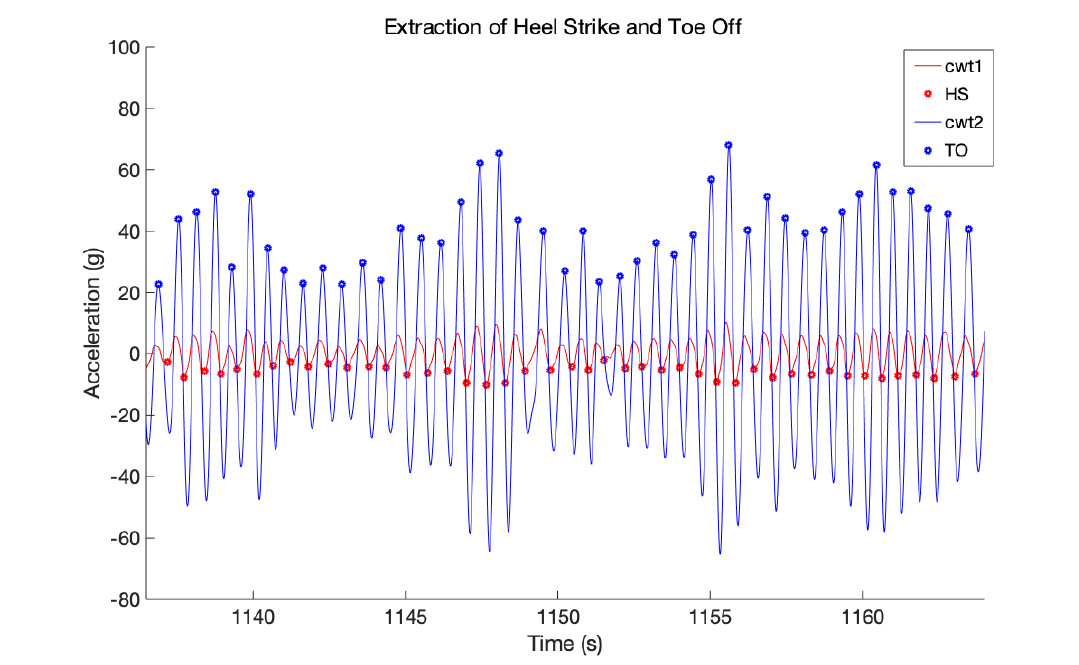
Figure 4. Temporal representation of first–order (CWT1, in red) and second–order (CWT2, in blue) Continuous Wavelet Transform from AP acceleration. The first local minima indicate the HS events (red circles), the second local maxima indicate the TO events (blue